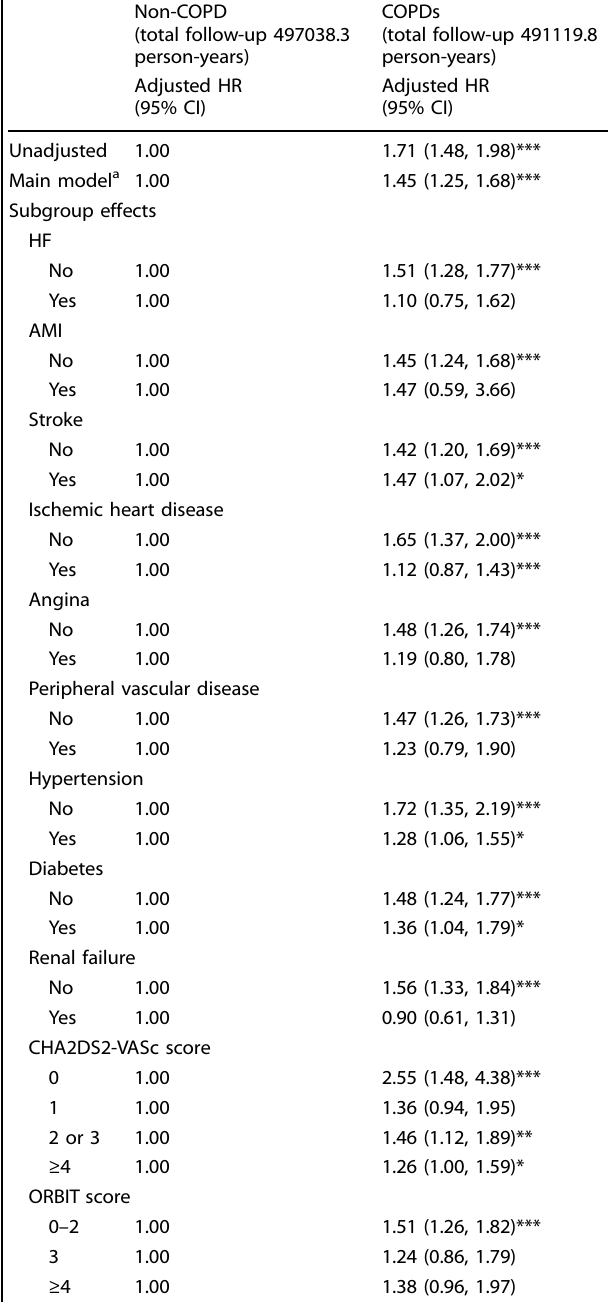
Table 2. Risk of VA between the COPD and comparison cohorts. Non-COPD (total follow-up 497038.3